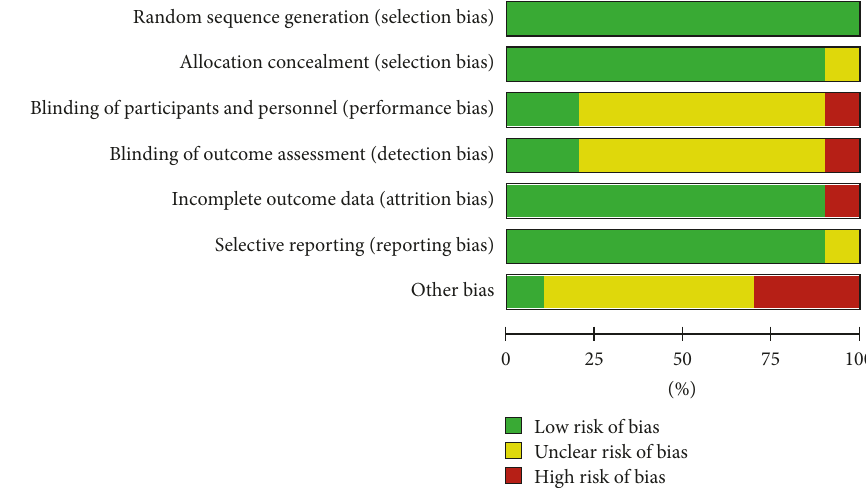
Figure 2: Risk of bias graph: review authors’ judgments about each risk of bias item presented as percentages across all included studies.